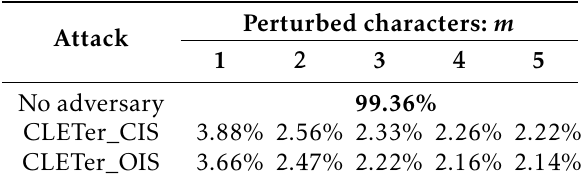
Table 4. The adversarial attack results on CNN model